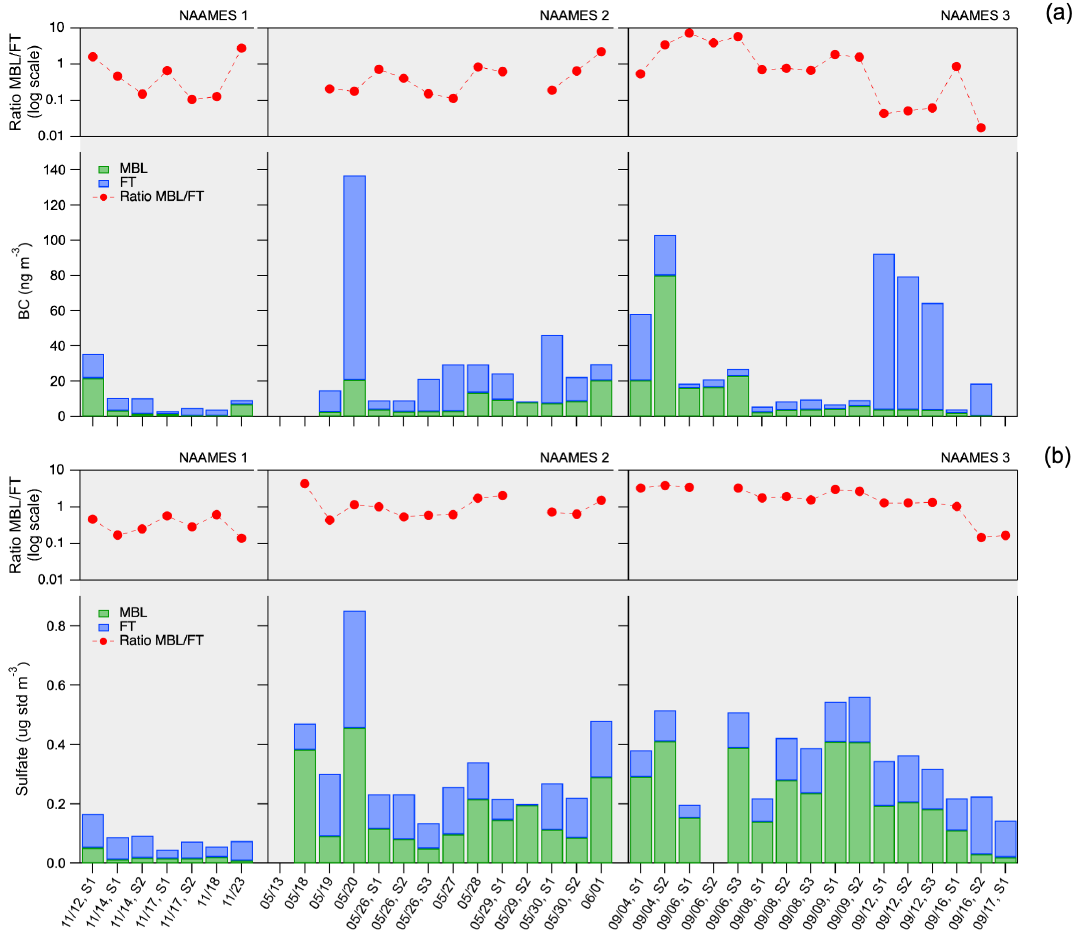
Figure 6. MBL (green bars) and FT (blue bars) mean values of BC (a) , and sulfate (b) for each C-130 spirals during NAAMES-1, NAAMES- 2, and NAAMES-3. The red circles denote the ratio between MBL and FT mean values for the parameters considered (logarithmic